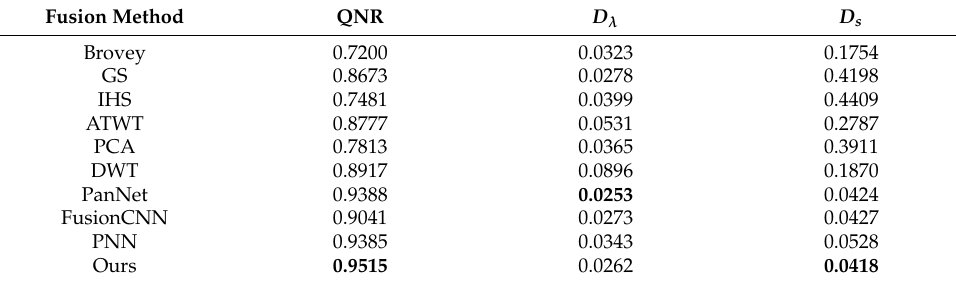
Figure 15. Fusion results for the fourth group of remote sensing image data. Table 5. The fourth group evaluation indexes of different fusion